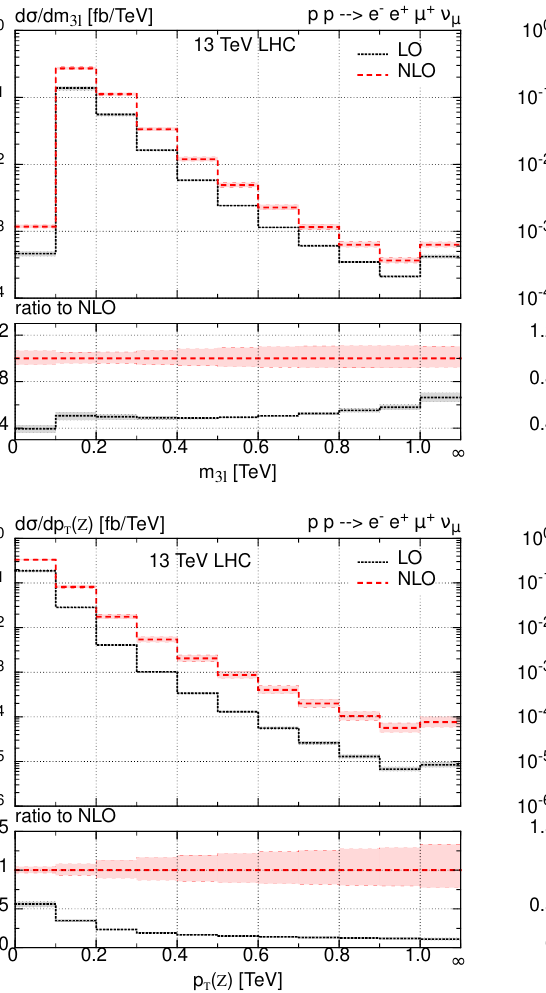
Figure 2 . The di(cid:11)erential distributions of m ( left-column ) and ZW (cid:0) ( right-column ) production in the e + e (cid:0) (cid:22) (cid:6) + (cid:0) E T channel at the LHC for p s = 13 TeV at LO and NLO in QCD obtained using MATRIX [95, 97, 99{104] for CMS (cid:12)ducial